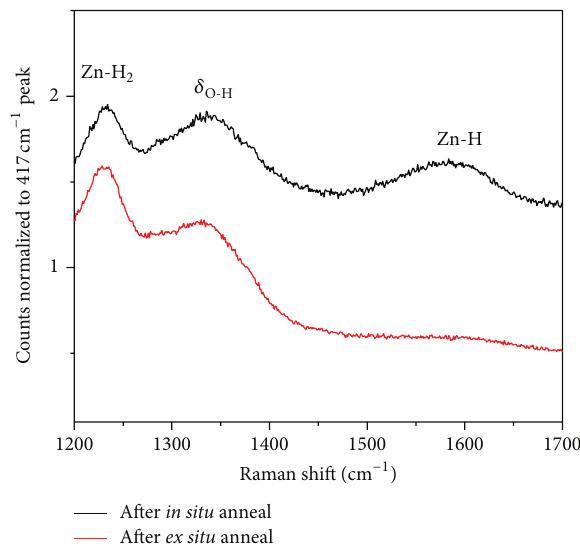
Figure 5: Raman spectra of a N-doped ZnO film show that excess H + boundtotheO 𝑖−1( oct ) andZn 𝑖−1( oct ) presentafterthe insitu anneal (black) is removed from the film after the ex situ 800 ∘ C O 2 anneal (red).